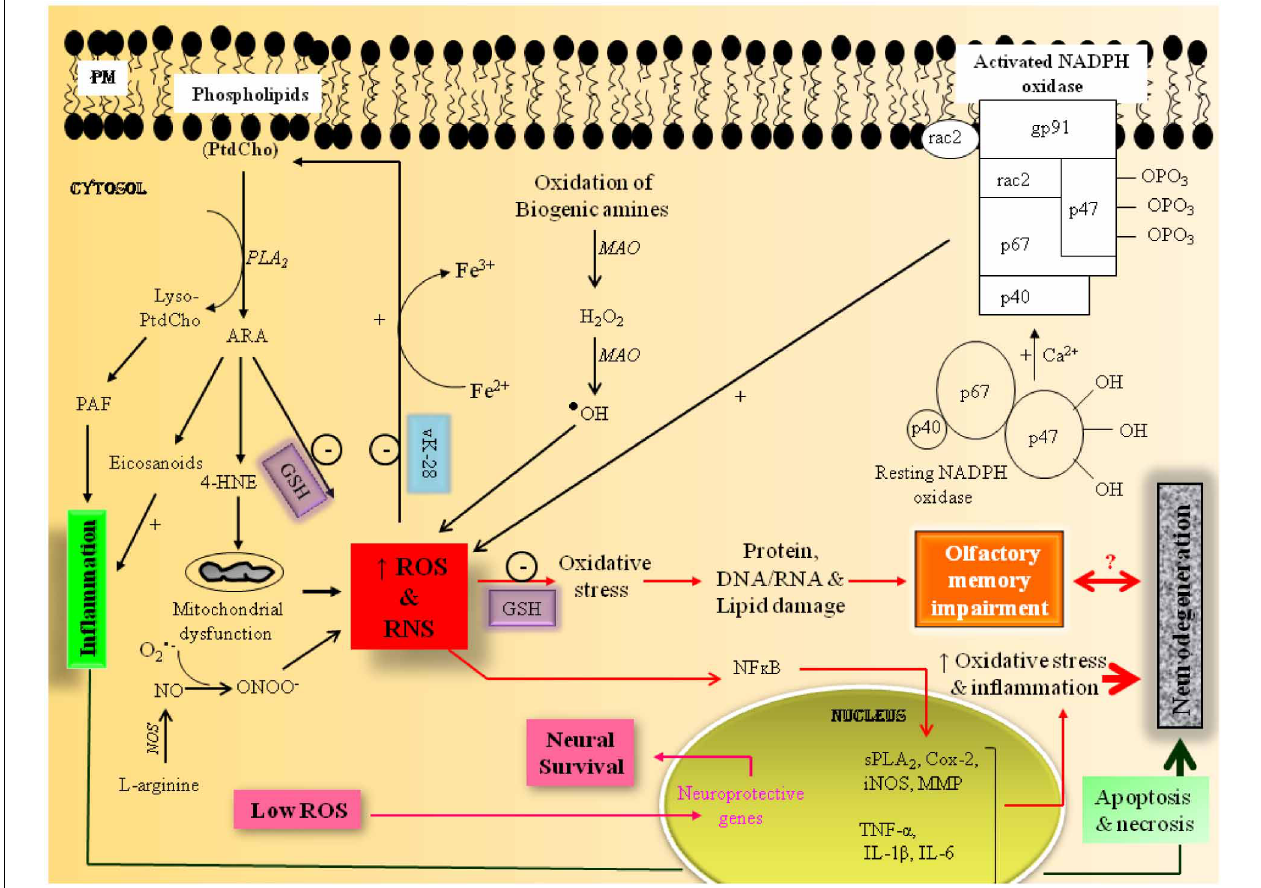
FIGURE 1 | Hypothetical scheme showing the potential molecular mechanisms involved with oxidative stress-mediated impairment of olfactory memory.